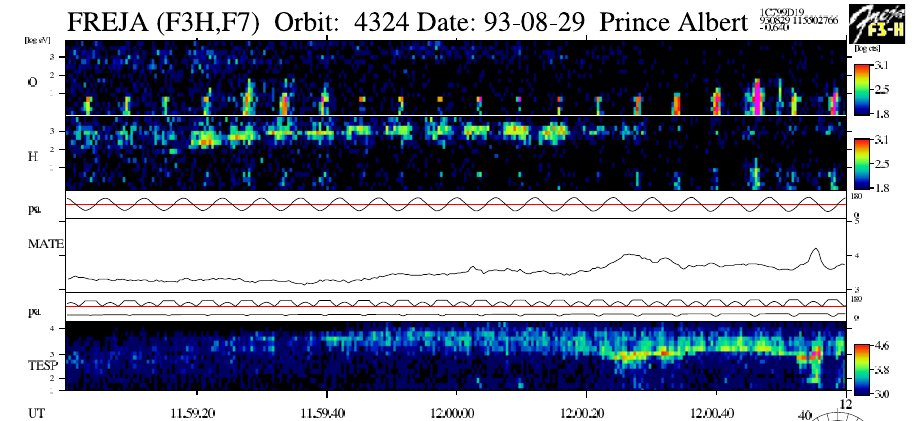
Fig. 14. A 2-min CSP showing increas- ing energy of precipitating ions in the period